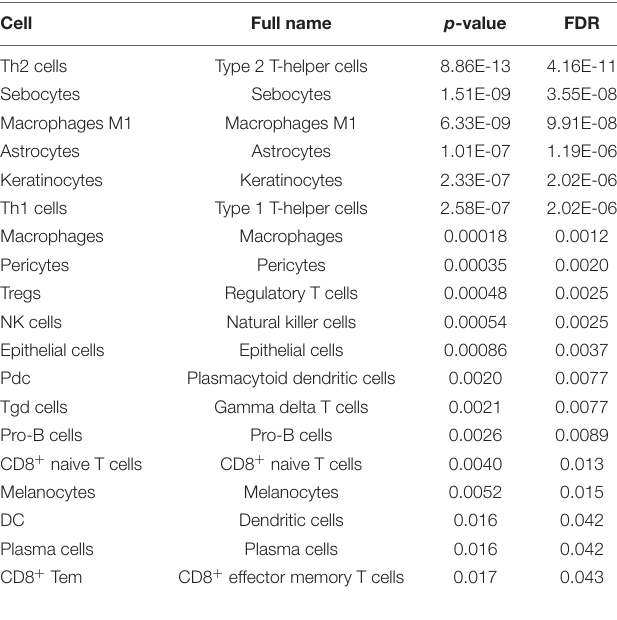
TABLE 2 | The detailed information of immune cells driven by the TP53 gene